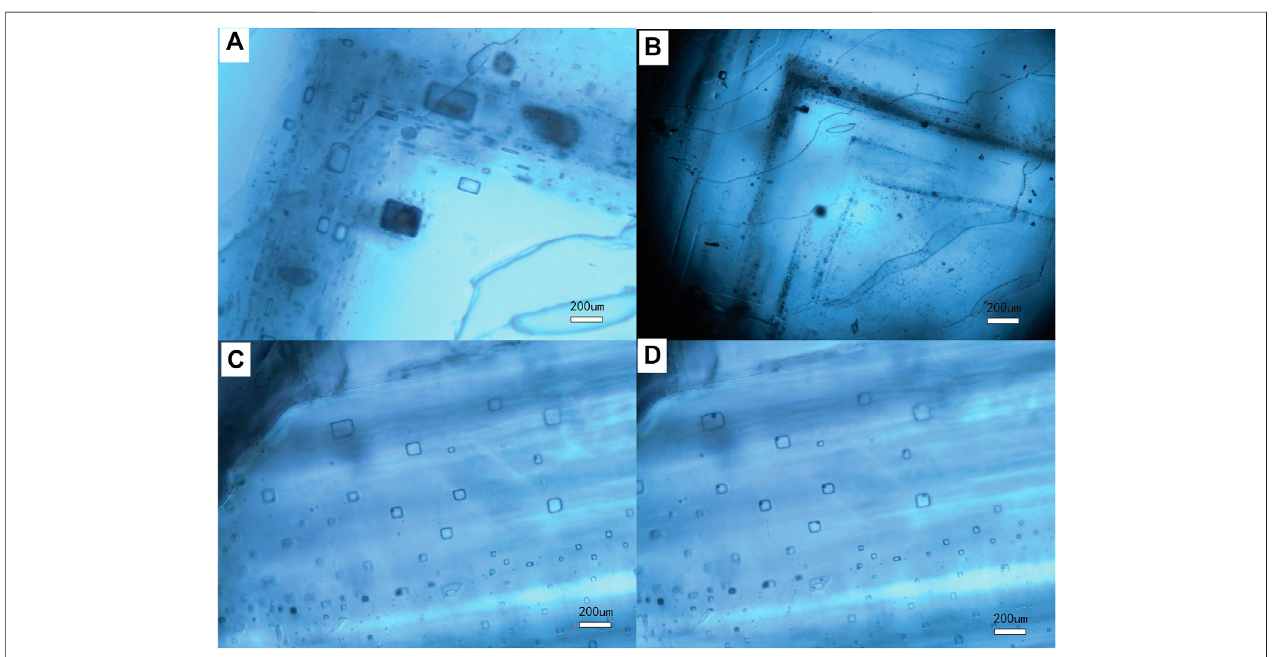
FIGURE6| Photosofhalite fl uid inclusions. (A,B) indicate theprimary chevron halite, sampledfrom BD-12. (C) isthe photo ofinclusionbeforefreezing. (D) shows that vapor bubbles emerged after freezing, sampled from BD-17.